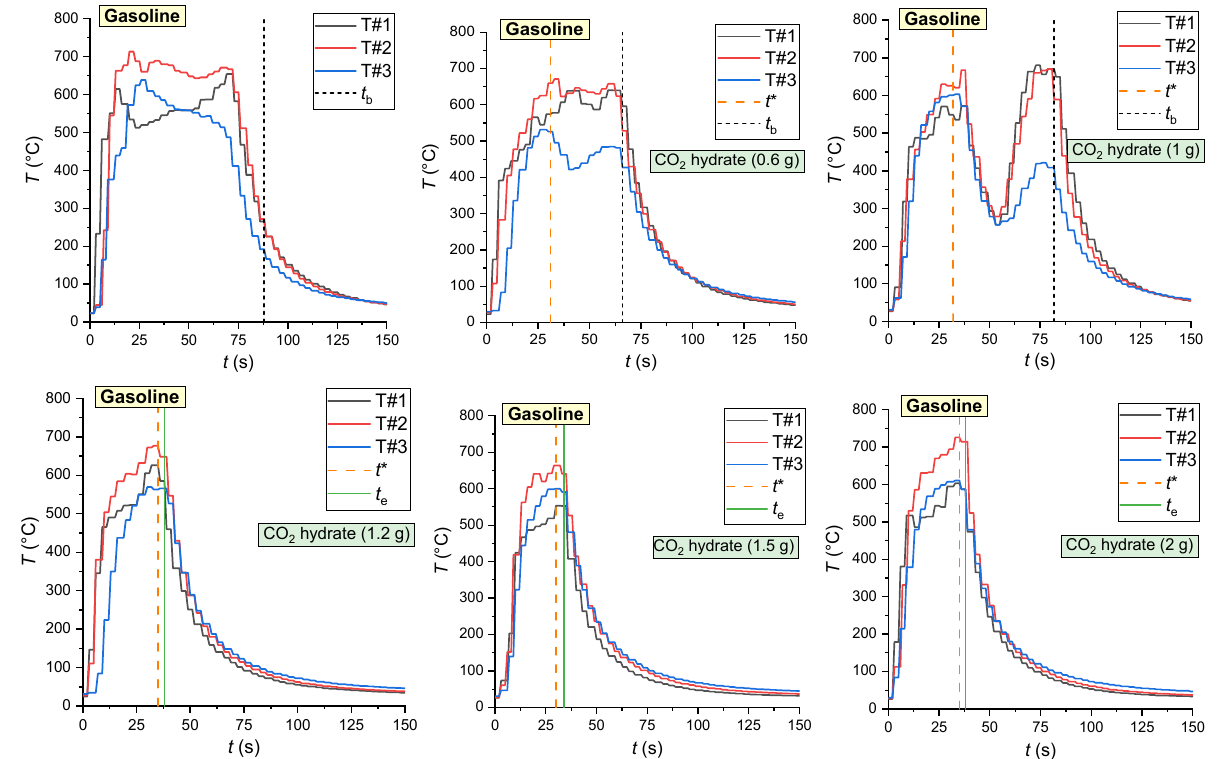
Figure 12. Flame temperature variation dynamics (gasoline, V 0 ≈ 3 mL, d f ≈ 50 mm, S f ≈ 20 cm 2 ) without extinguishing and when using CO 2 hydrate powder ( m g = 0.6–2 g). Figure 13 presents the temperature trends illustrating the flame temperature variation dynamics for laboratory-scale pool fires of different diameters ( d f = 50–75 mm) consisting of gasoline ( V 0 ≈ 3 mL) and burning without extinguishing and when suppressed by CO 2 hydrate powder. The trends were obtained using thermocouple measurement. It was established (Figure 13a) that with V 0 ≈ const, an increase in the fire surface area in the range of S f = 20–45 cm 2 leads to a nonlinear decrease in the flammable liquid fire extinction time from 88 s to 44 s (because it burns evenly at the same rate across the entire fire surface area). According to the generalized data (Figure 13b), the minimum required discharge density of the CO 2 hydrate per unit area of the flammable liquid surface must be ζ = 0.5–0.6 kg/m 2 . Gasoline T#1 T#2 d f ≈ 65 mm